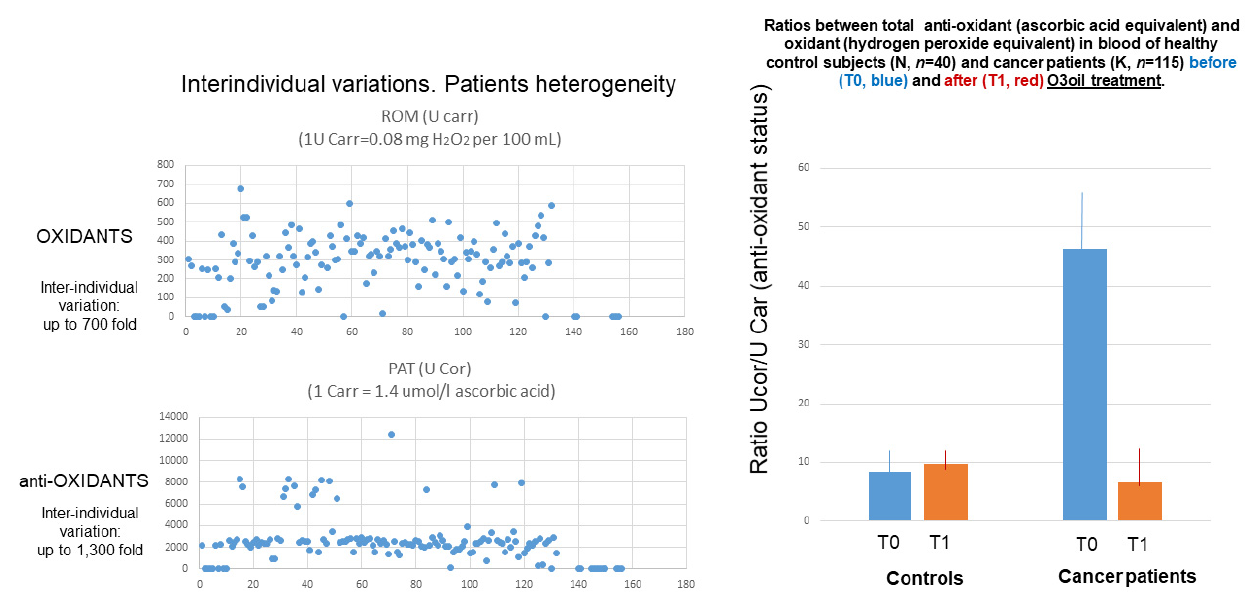
Figure 18. Analysis of oxidative status in the blood plasma of 115 cancer patients. The level of antioxidant was higher in cancer patients as compared with controls (left panel, blue columns). HOO treatment in cancer patients decreased the high level of antioxidant (left panel, red columns) moving back their amount to the level of unaffected controls.